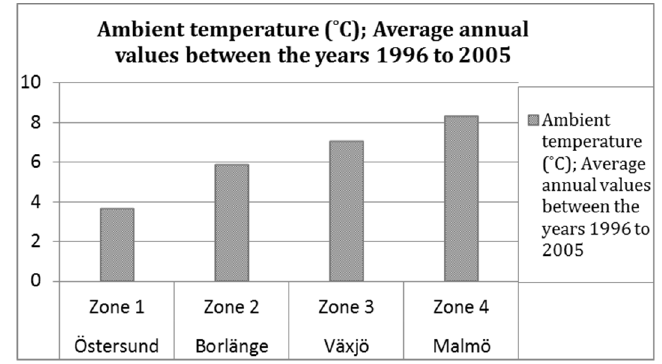
Figure 2. Ambient temperature (°C); average values from 1996–2005.